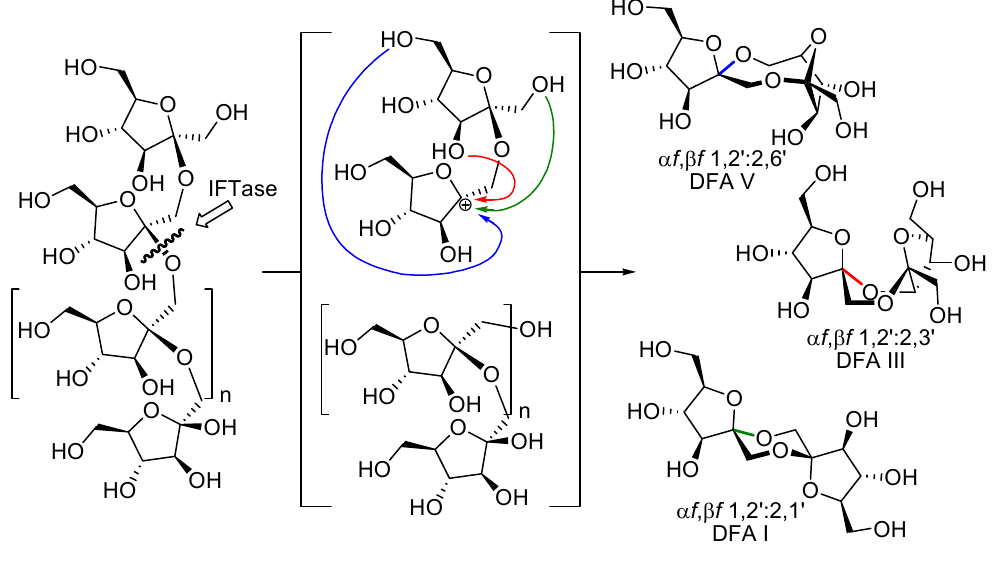
Figure 14 . IFTase-catalyzed synthesis of